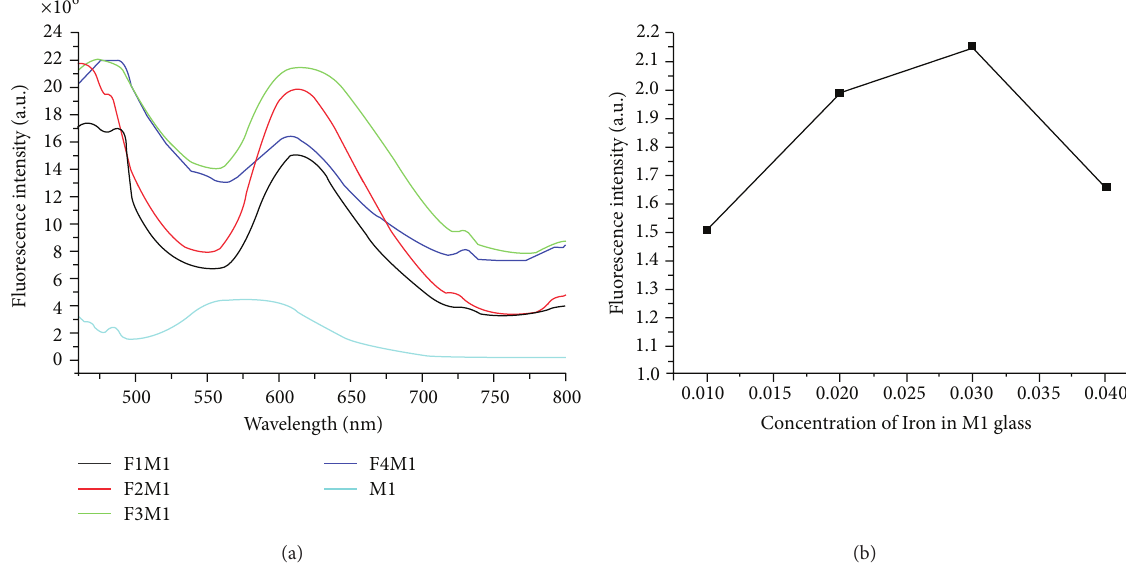
Figure 5: (a) Photoluminescence spectra of Fe-MG SiO 2 glasses (F1M1, F2M1, F3M1, and F4M1) and M1 glass. (b) Variation of photoluminescence intensity with molar concentration of Fe-I in F 𝑥 M1 glasses ( 𝑥 = 1 – 4 ).